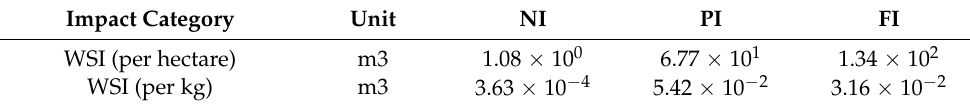
Table 9. Water footprint measured using the water scarcity index (WSI) approach.